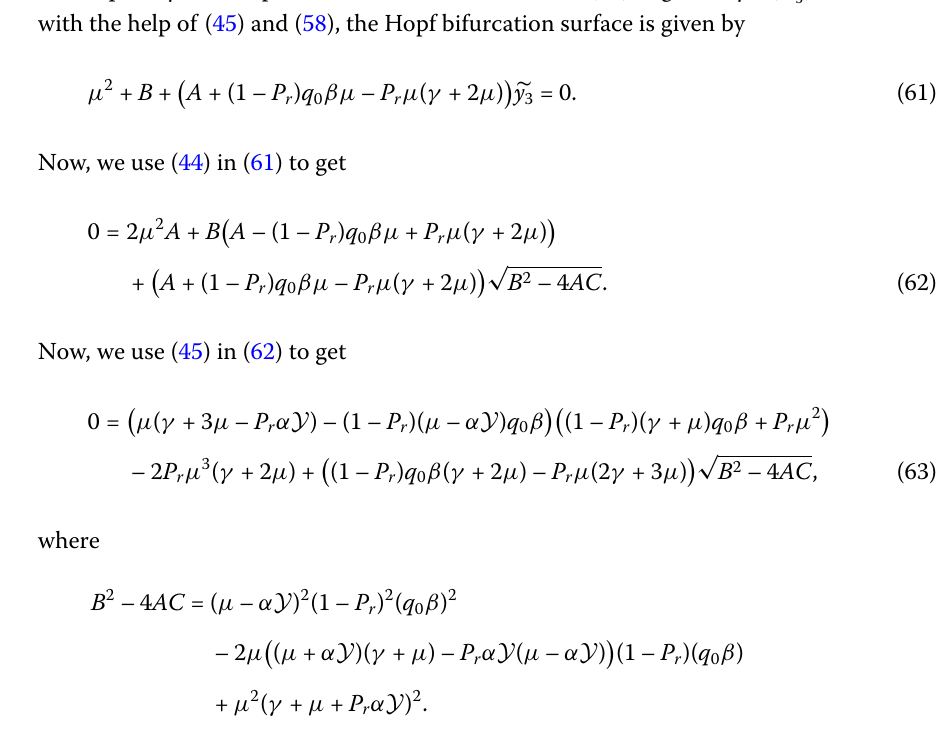
where ρ is the eigenvalue. If det ( J E ) > 0, while tr ( J E ) switches its sign when some